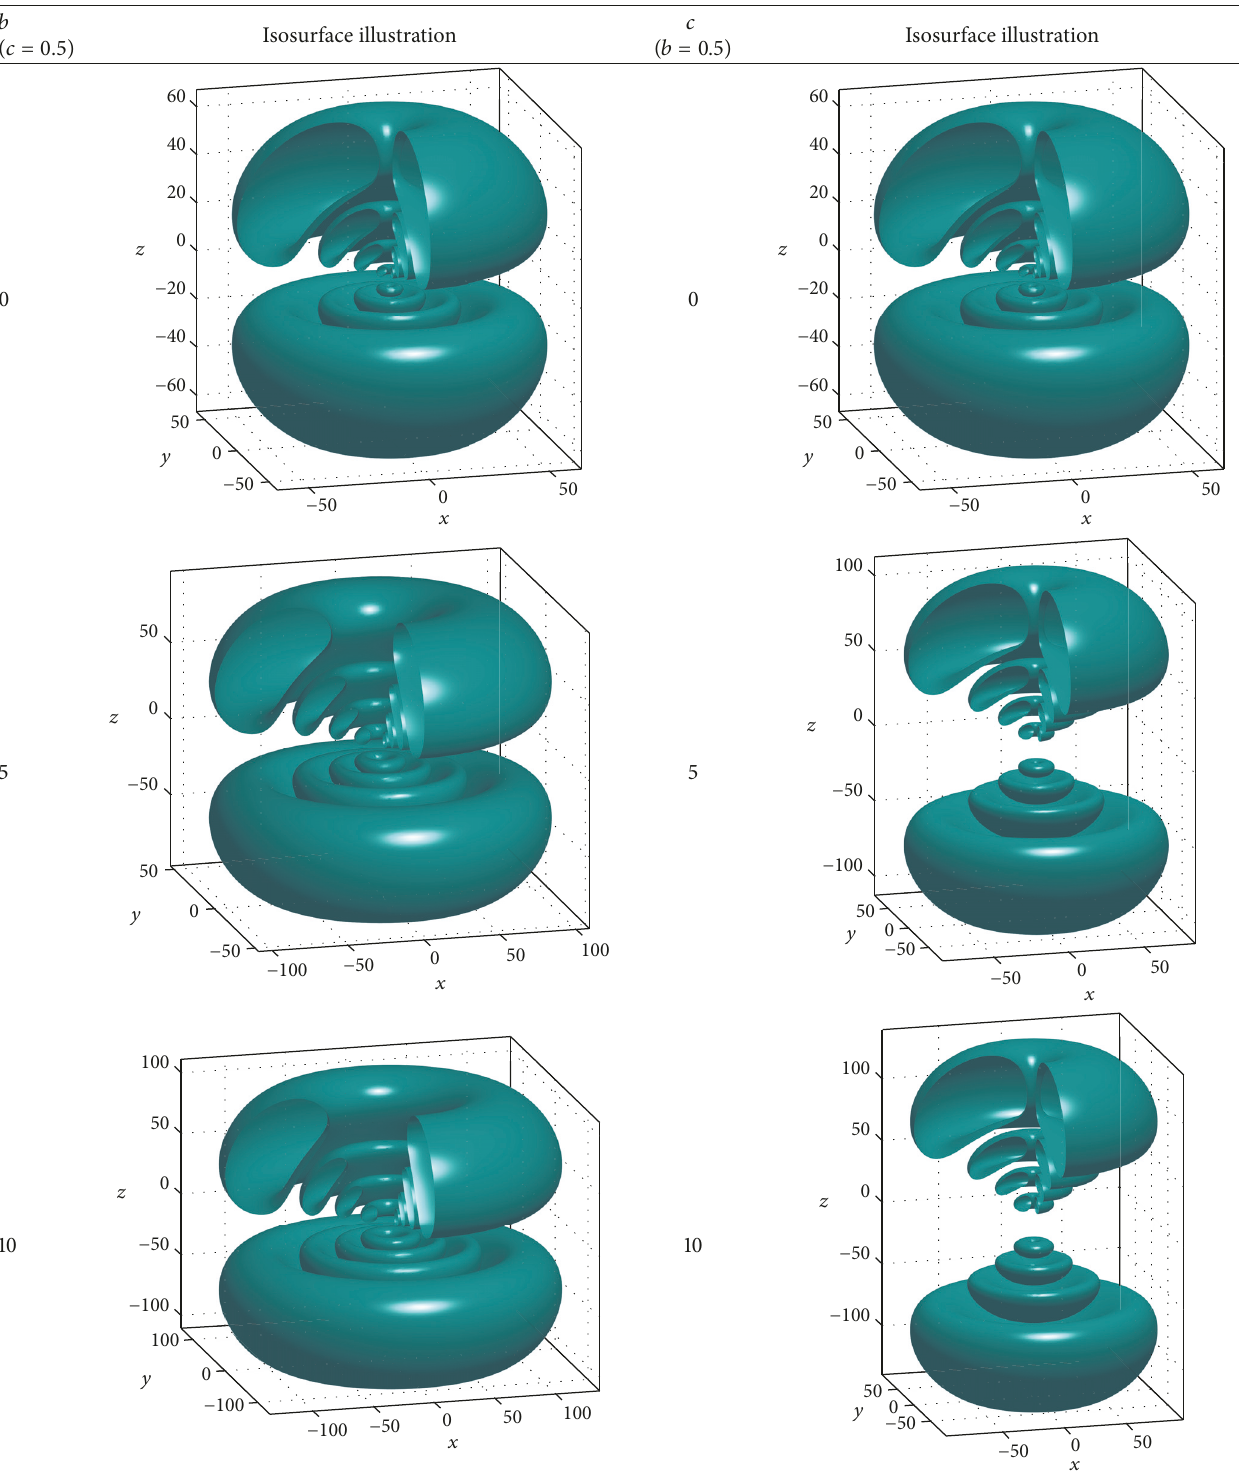
Table 4: The isosurface illustration of the state (5, 1, 0) with various values of 𝑏 and 𝑐 . 𝑏 (𝑐 = 0.5) Isosurface illustration